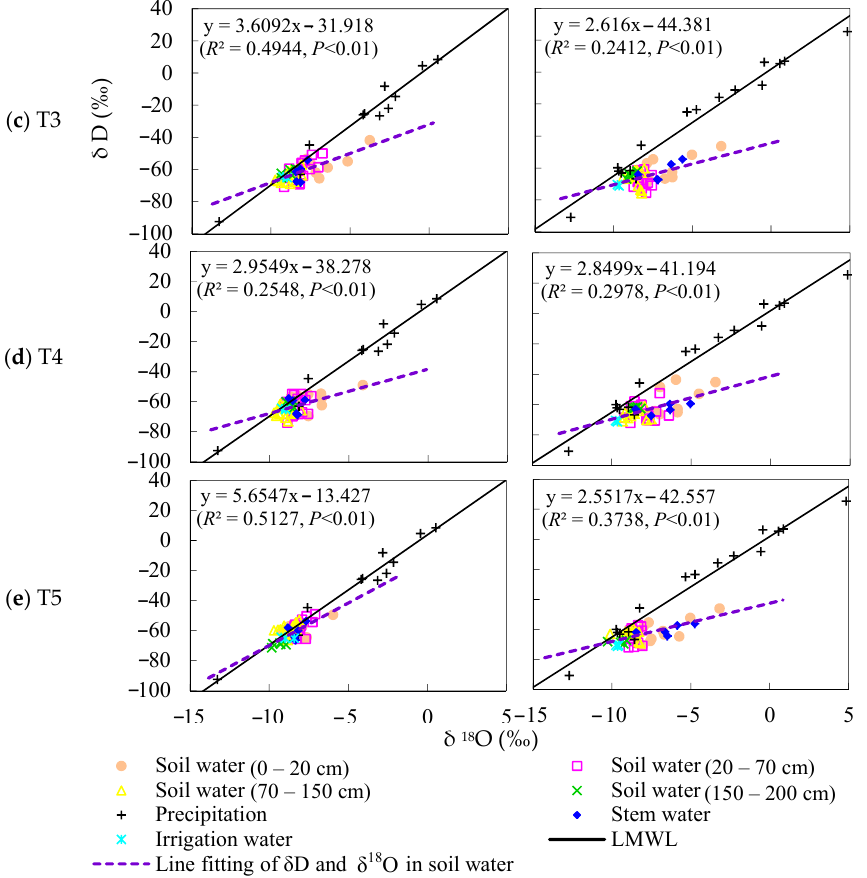
Figure 4. δ D- δ 18 O relationship for the water samples under treatment: ( a ) T1, ( b ) T2, ( c ) T3, ( d ) T4, and ( e ) T5 in the 2014 and 2015 growing seasons.